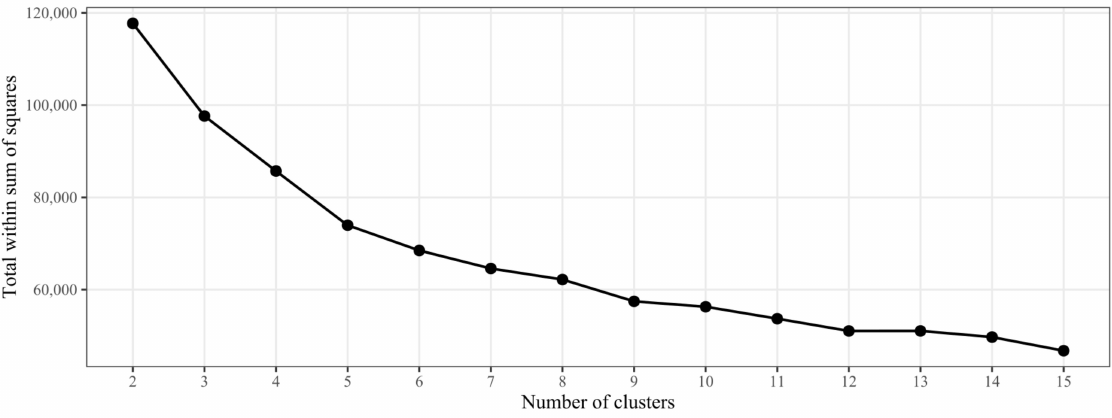
Figure 4. Mean variation of clusters v k (the elbow method) indicates the number of clusters from six to